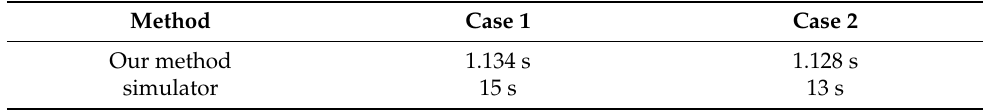
Figure 14. The loss of both saturation and pressure field for the two geo-models when compared with labels. Table 4. The time-consuming nature of both the network and